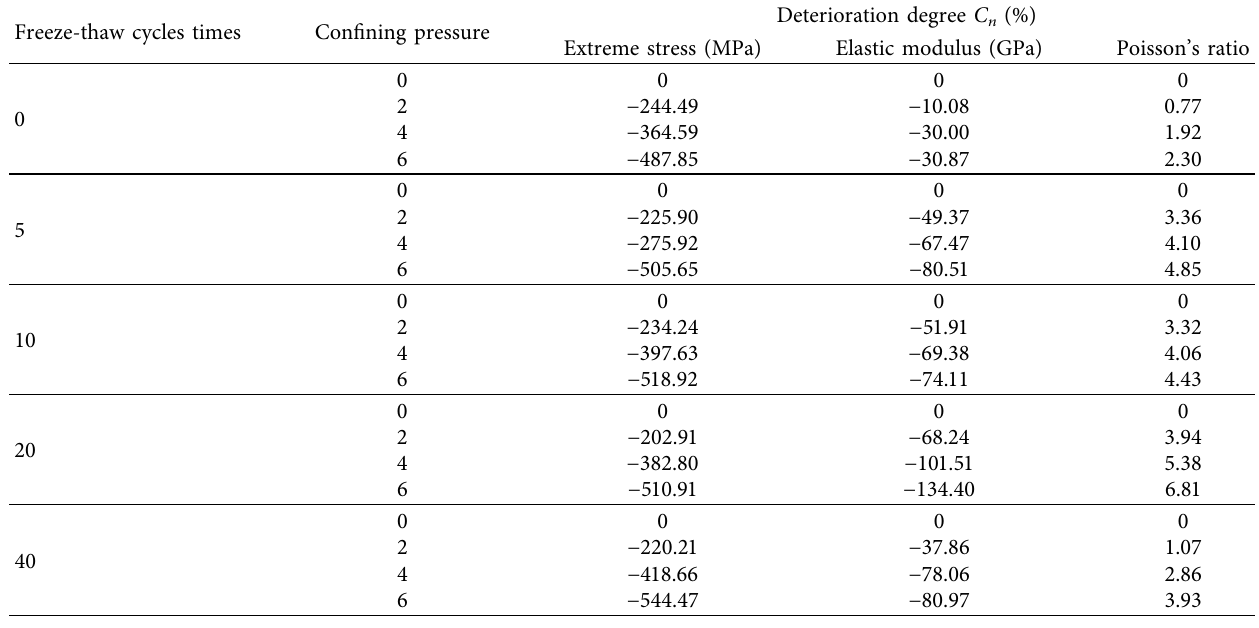
Table 2: Deterioration degree of sandstone mechanical parameters under different confining